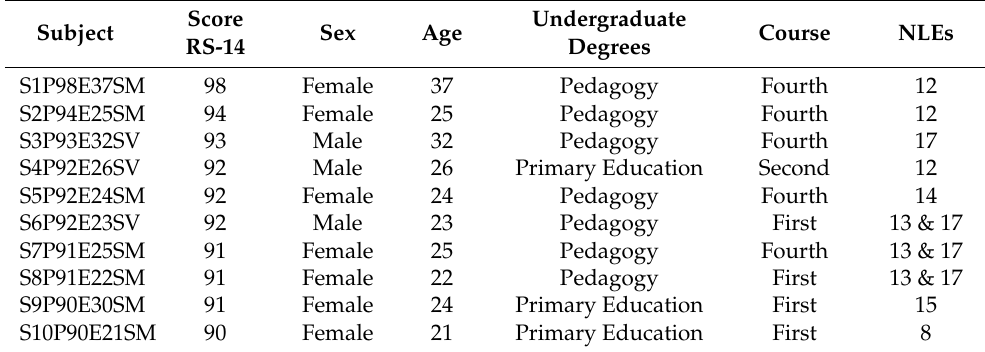
Table 4. Characteristics of the participants ( n =